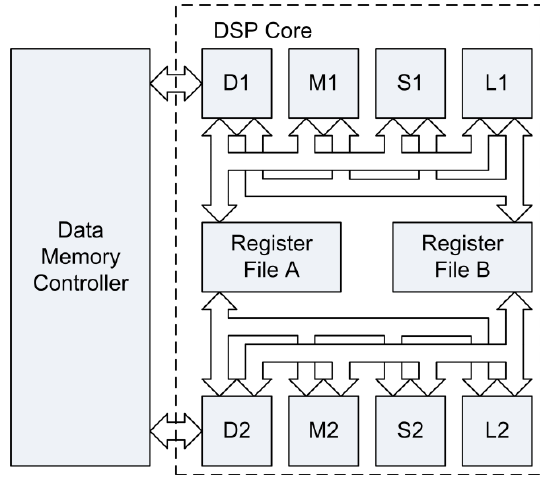
Fig. 2. Structure of one TMS320C6678 processor